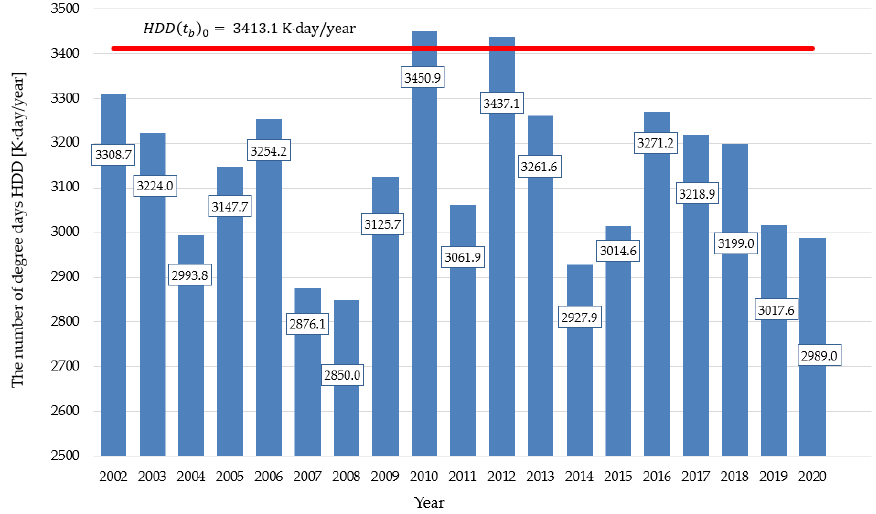
Figure 5. Number of heating season degree days determined for 2002–2020 based on temperature data of MPEC Ł om ż a Heat Plant and typical heating season (1991–2020) [87].